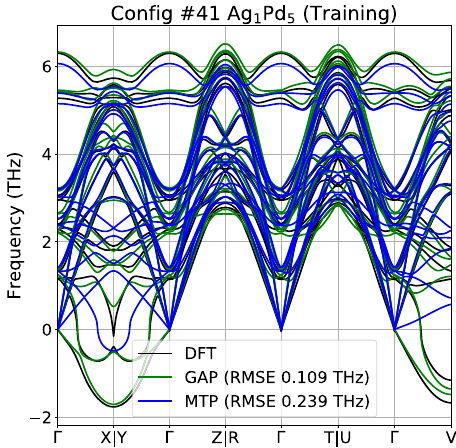
Fig. 3 Phonon dispersion curves for a 6-atom structure with 16 at. % Ag. Both the RMS errors within parentheses represents the integrated error across all eigenvalues sampled on a 13 × 13 × 13 grid in the Brillouin zone. According to DFT, this structure is not dynamically stable. Both GAP and MTP recover this dynamic instability, although GAP is more accurate. Note that this seed con fi guration was included in the active-learned dataset that the potentials were fi tted to.